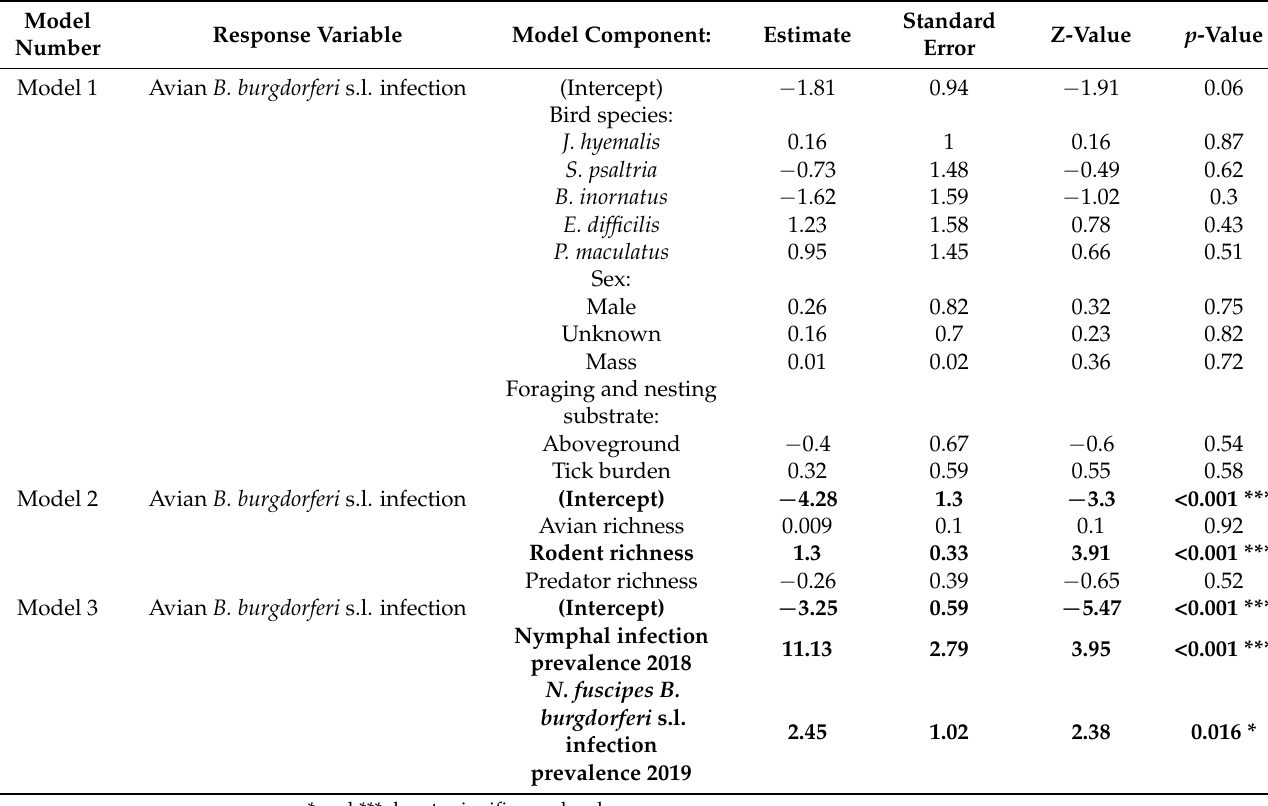
Table 3. Binomial model results of natural history and host demographic variables, and host community characteristics as predictors of avian B. burgdorferi s.l. infection status with site as a random variable.